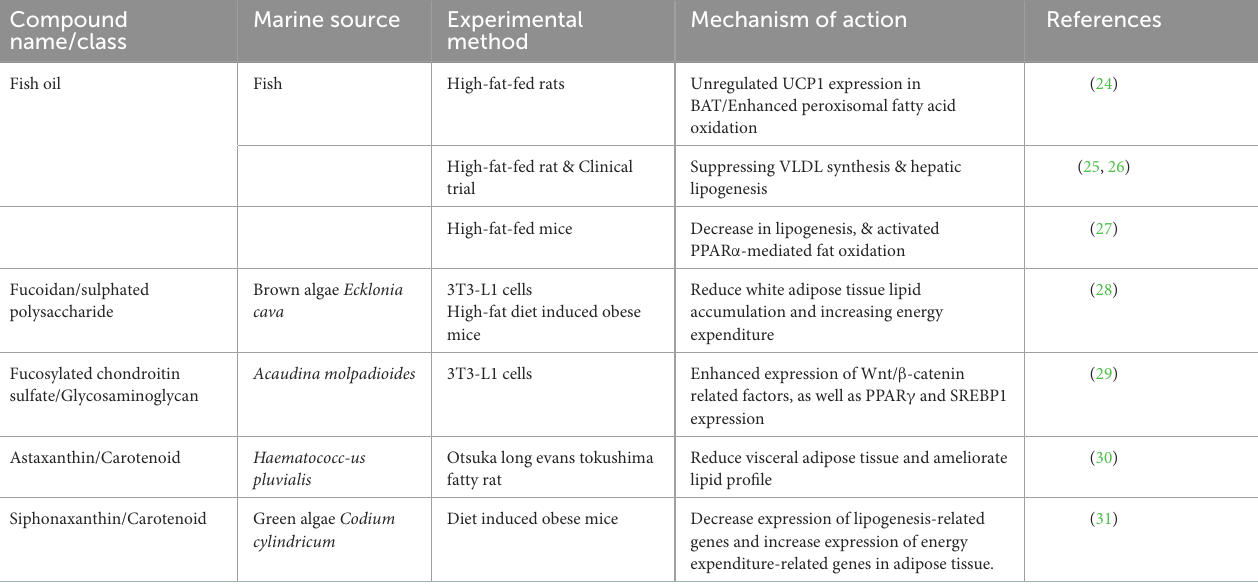
TABLE 1 List of compounds isolated from marine sources with potential anti-obesity